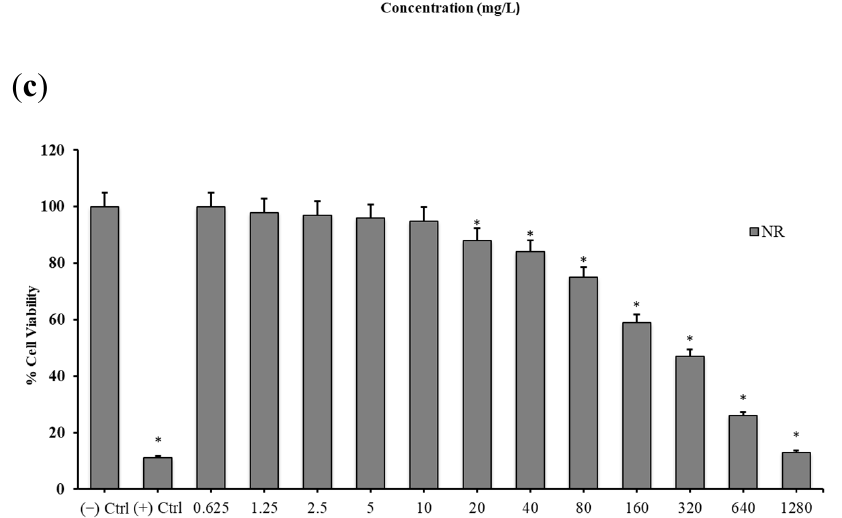
Figure 3. Cell viability assay of titanium diboride (TiB 2 ) NPs on human pulmonary alveolar cells. ( a )—3-(4,5-Dimethylthiazol-2-yl)-2,5-diphenyltetrazolium bromide (MTT) cell viability analysis of TiB 2 NPs, ( b )—lactate dehydrogenase (LDH) cytotoxicity analysis TiB 2 NPs and ( c )—neutral red (NR) cell viability analysis of TiB 2 NPs on human pulmonary alveolar cells. * SPSS program, Duncan’s test was performed for each experiment for statistical calculations at a significance level ≤ 0.05.